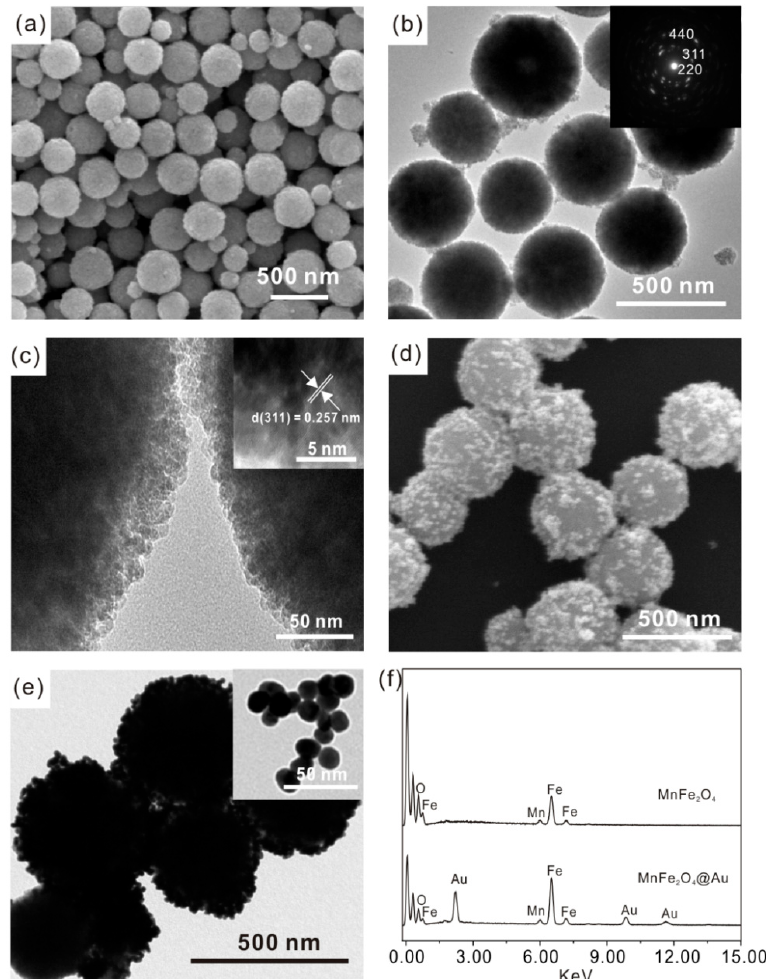
Figure 1. Characterization of mesoporous MnFe 2 O 4 /Au hybrid nanospheres: ( a ) Scanning electron microscopy (SEM) image of MnFe 2 O 4 NCs; ( b ) and ( c ) The High Resolution Transmission Electron Microscopy (HRTEM) images of MnFe 2 O 4 NCs, inset in panel b is the corresponding selected-area electron diffraction (SAED) pattern; ( d ) SEM image of MnFe 2 O 4 /Au hybrid nanospheres; ( e ) TEM image of MnFe 2 O 4 /Au hybrid nanospheres, inset in panel e is the TEM image of Au nanoparticle decorated on the surface of MnFe 2 O 4 NCs; ( f ) Energy-dispersive X-ray spectrum (EDS) of MnFe 2 O 4 NCs and MnFe 2 O 4 /Au hybrid nanospheres.